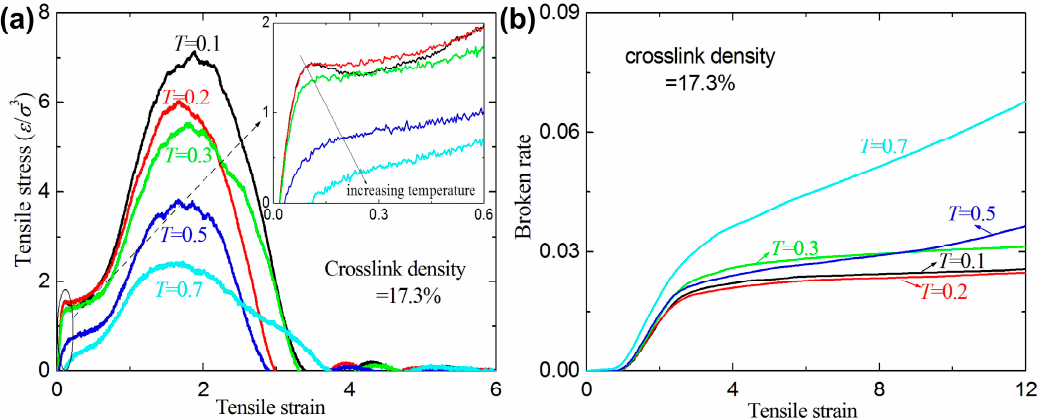
Figure 5. ( a ) The tensile stress ‐ strain curves for a given crosslink density of 17.3% at different temperatures; and ( b ) the broken ratio versus temperature.